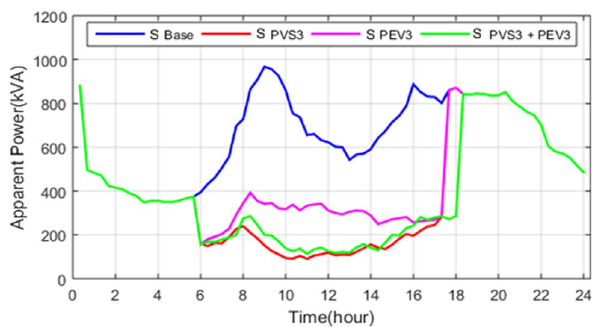
Figure 4. Test system.